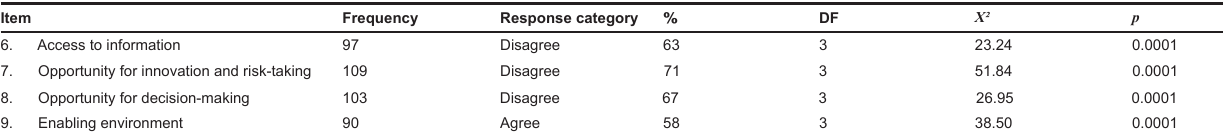
Table 4 Chi-square results for empowering